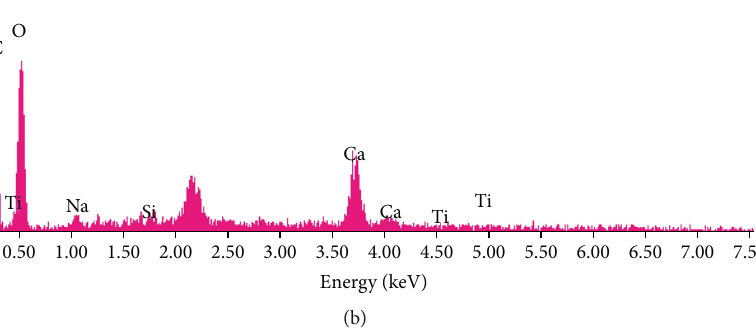
Figure 3: EDX patterns of (a) unmodi fi ed GP and (b) modi fi ed